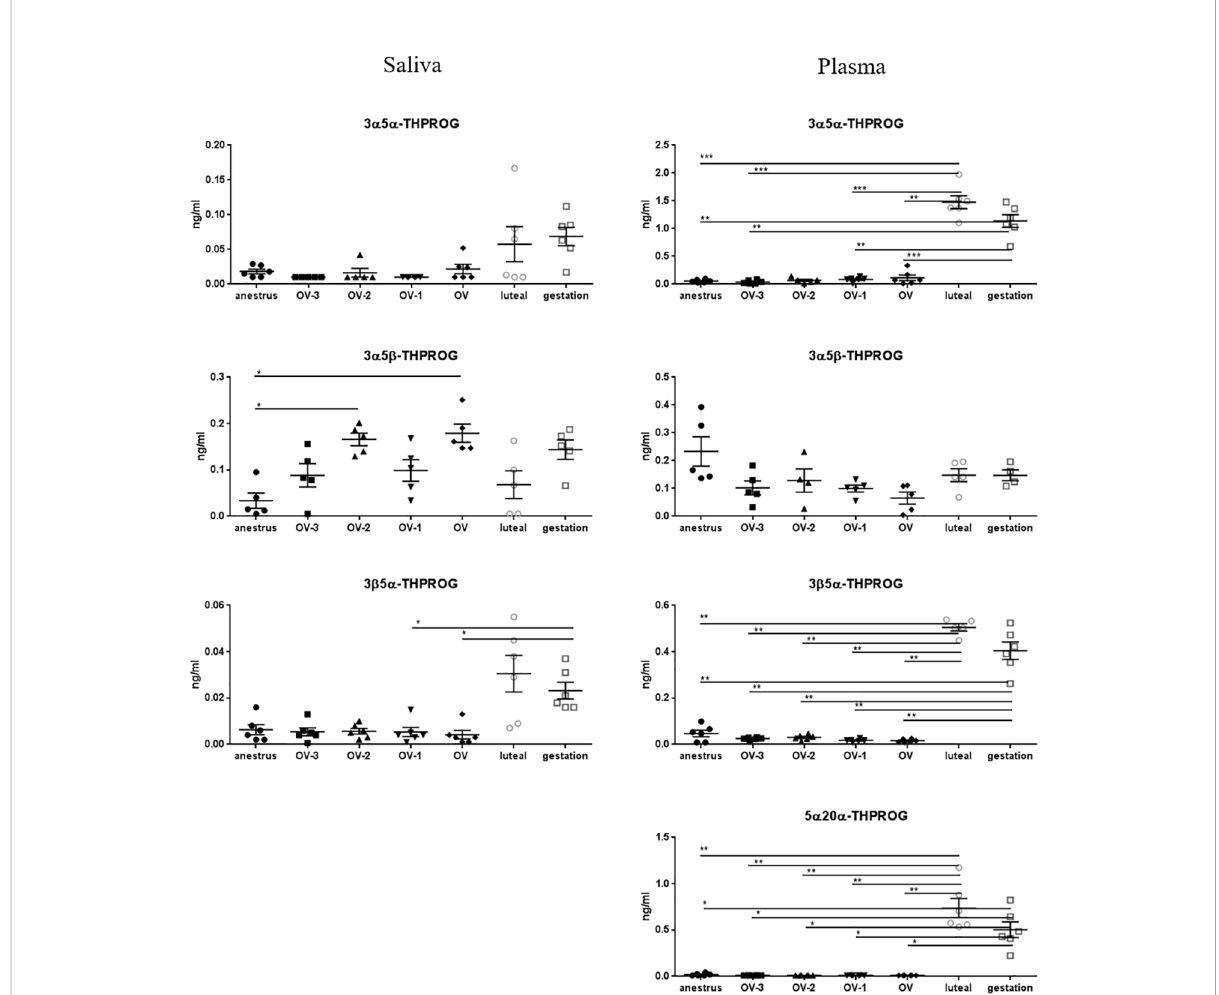
FIGURE 3 Gas chromatography coupled to tandem mass spectrometry (GC-MS/MS) measurements of the concentrations of 3 a 5 a - tetrahydroprogesterone (3 a 5 a -THPROG), 3 a 5 b -THPROG, 3 b 5 a -THPROG and 5 a 20 a -THPROG (ng/mL ± SEM) in mare saliva and plasma collected during anestrus, during follicular phase 3 days (OV-3), 2 days (OV-2) and 1 day (OV-1) before ovulation, the day when ovulation was detected (OV), during luteal phase 6 days post-ovulation (luteal), during gestation 18 days post-ovulation (gestation). For each steroid, the y-axis was standardized to the maximal concentration, so that the variations are easy-to-read. Statistical differences between physiological stages: * P < 0.05, ** P < 0.01, *** P <